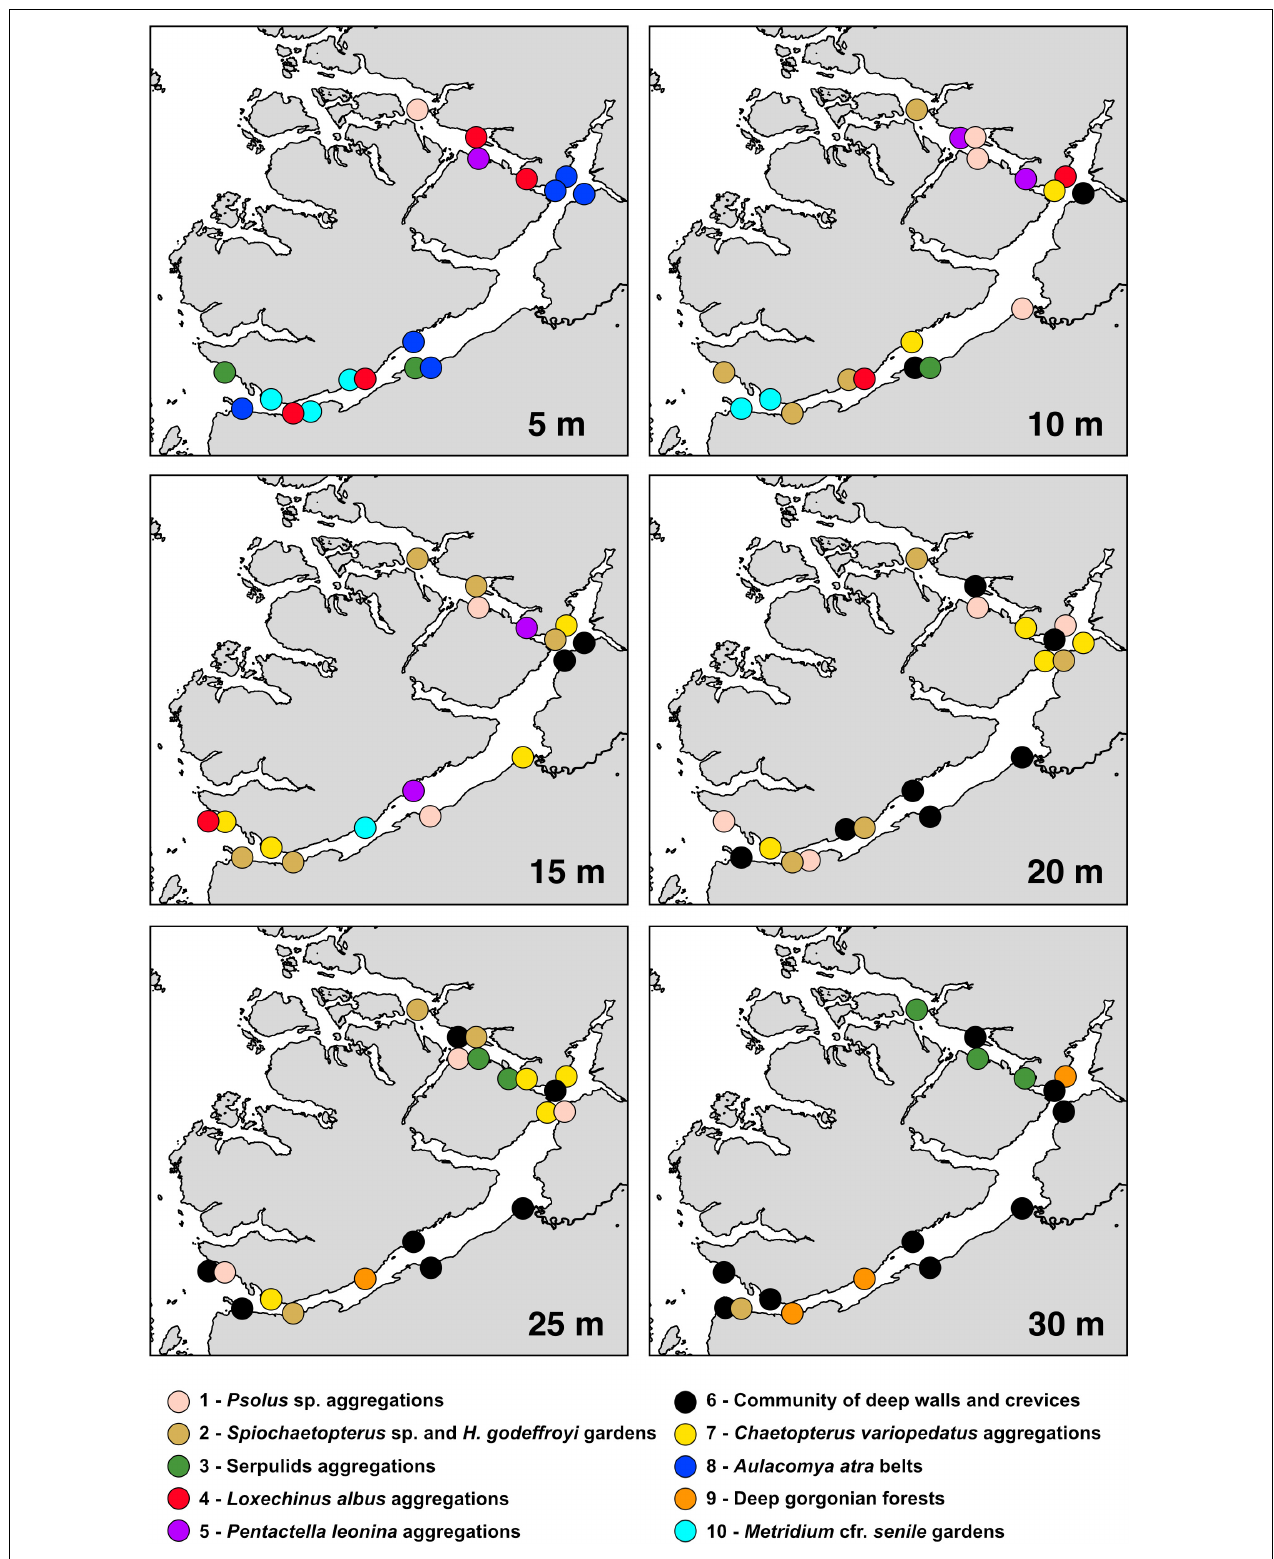
FIGURE 6 | Distribution maps. Spatial distribution of the 10 megabenthic communities identified in the cluster analysis at the six analyzed depths along the Puyuhuapi–Jacaf fiord system.